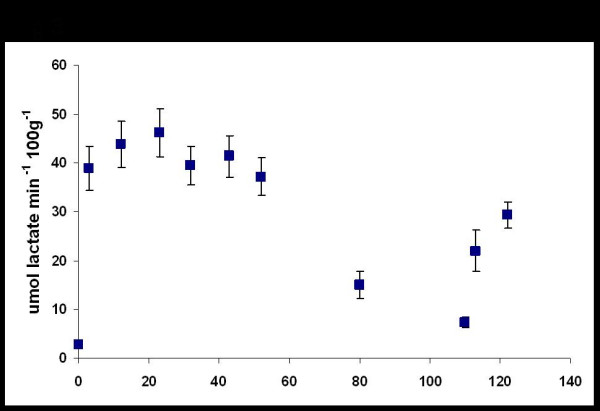
Represents muscle lactate efflux measured during rest and during the 3rd to fourth minute of contraction (this is when a venous blood sample was obtained) and during the first 2 minutes of recovery. Peak lactate efflux muscle was similar during the first 3 periods of muscle contraction. Following 60 min recovery lactate efflux had returned to baseline. The black bars at the top of the graph represent the period of muscle stimulation.